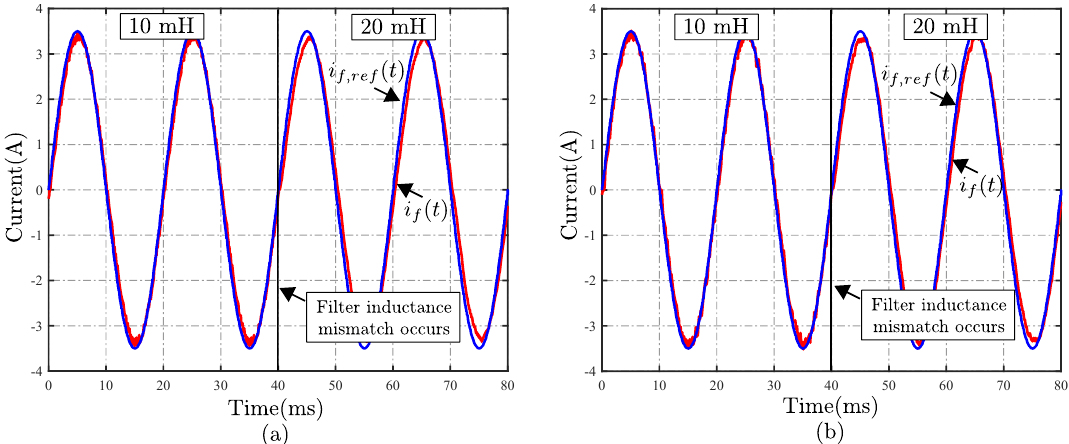
Figure 10. Experimental results for a step-change of +100% from 10 mH to 20 mH on the filter inductance value at t = 40 ms. ( a ) conventional FCS [24]; ( b ) proposed